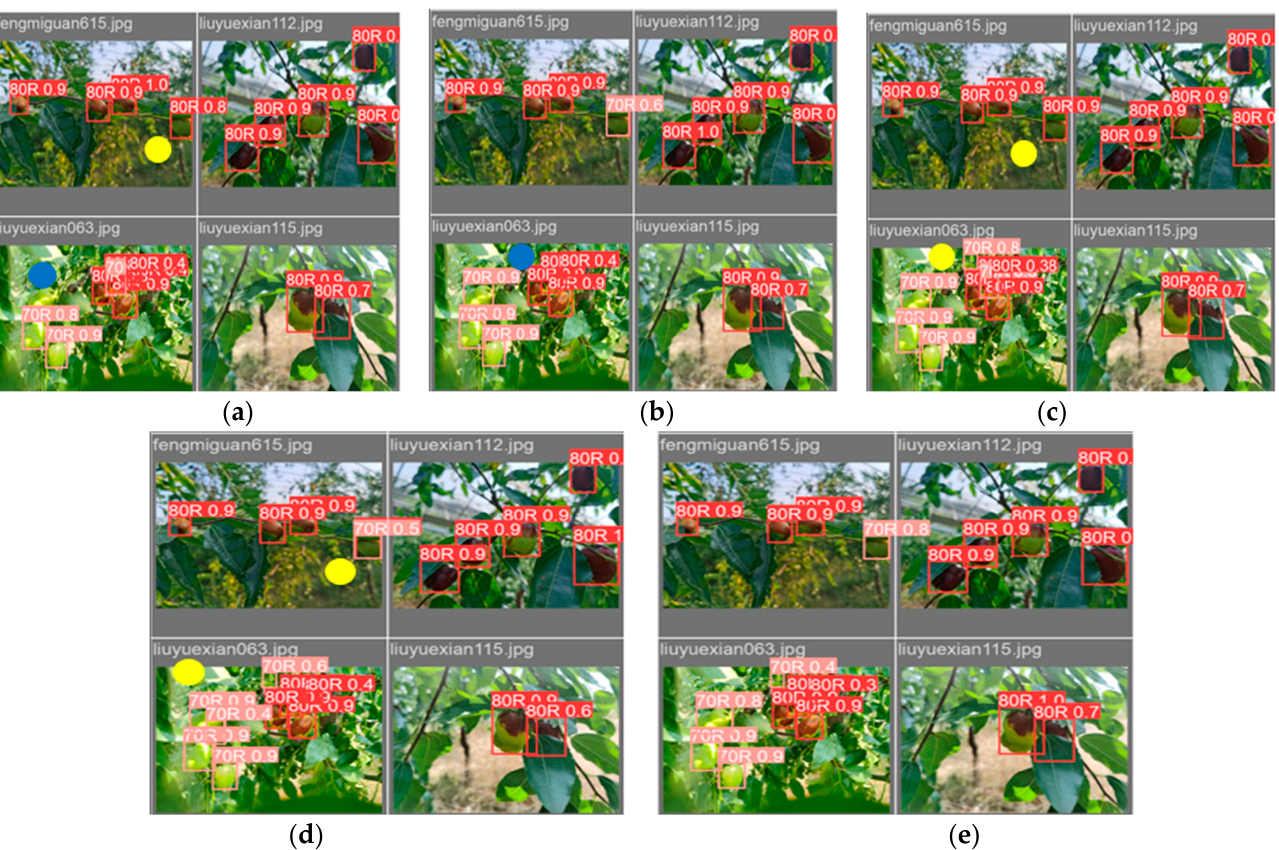
Figure 5. Result of four batches of images tested on the test set using the methods: ( a ) YOLOv3-tiny; ( b ) YOLOv4-tiny; ( c ) YOLOv5s; ( d ) YOLOv7-tiny; ( e ) Table 4. Performance of the methods on the test set.